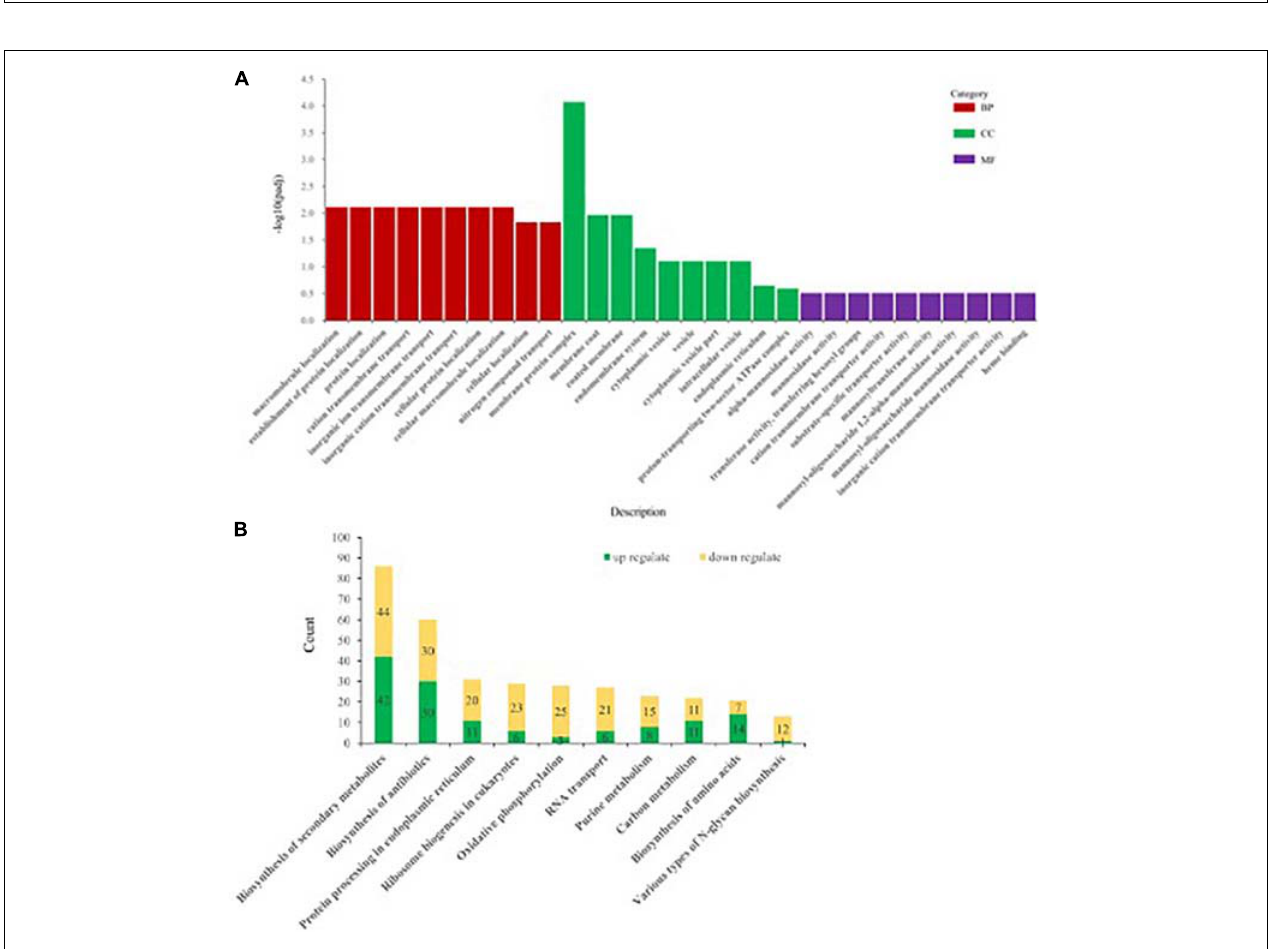
FIGURE 6 | The annotation of differentially expressed genes (DEGs) of Ps. camelliae-sinensis strain GZHS-2017-010 between PCA-treated hyphae vs. CK-treated hyphae. (A) The annotation of DEGs using Gene Ontology (GO). “BP,” “CC,” and “MF” in the sub-figure represent biological process, cellular component, and molecular function. The x -coordinate represent GO term of BP, CC, and MF, and the y -coordinate represent -log10padj. (B) The annotation of DEGs using Kyoto Encyclopedia of Genes and Genomes (KEGG). The x -coordinate represent the description of the pathway, and the y -coordinate represent count numbers in the